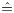
Overlay of the MRI magnitude data (grayscale) and SVM results (color-coded).A: Iron oxide concentration map for the training phantom. B: Iron oxide concentration map for the test phantom. The image was registered to the training phantom. C: False positive voxels (=^ voxels that are falsely classified as containing labeled cells) in the test phantom (data from B). D: False negative voxels (=^ voxels that are falsely classified as not containing labeled cells) in the test phantom (data from B).